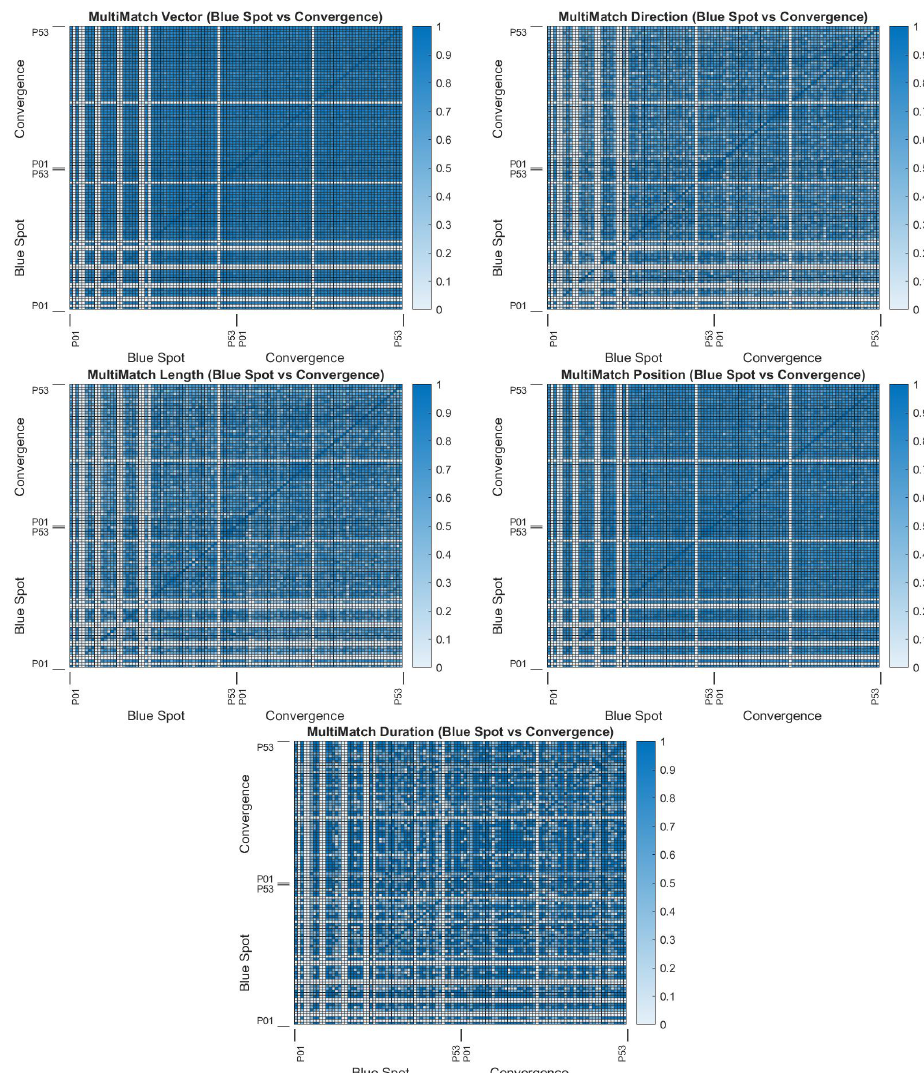
Figure 12. SoftMatch, ScanMatch, and MultiMatch heatmaps. Stimuli matched are Bernard Cohen’s Blue Spot (1966) and Jackson Pollock’s Convergence (1952). Darker values indicate higher